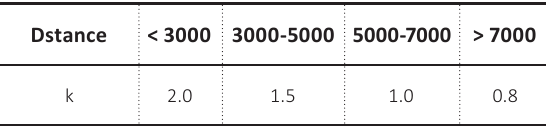
Table 1. Weighting of geographical distances between China and other